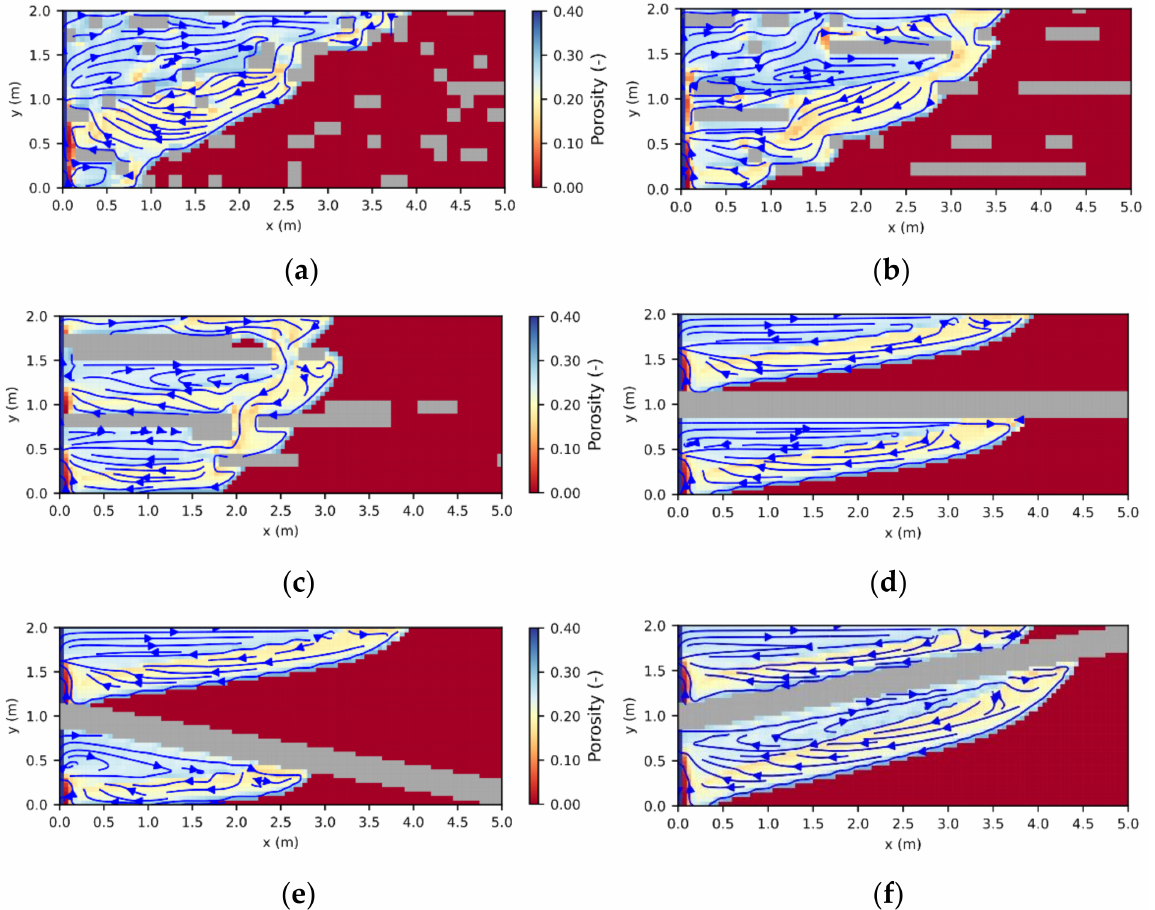
Figure 12. Porosity distribution after a simulation time of 2 years for heterogeneous potash seams with halitic inclusions for distributions of ( a ) 2:1, ( b ) 17:0.5, ( c ) 34:1 and intersecting layers with ( d ) 0 ◦ , ( e ) +10 ◦ , ( f ) − 10 ◦ inclination and k max = 5 × 10 − 4